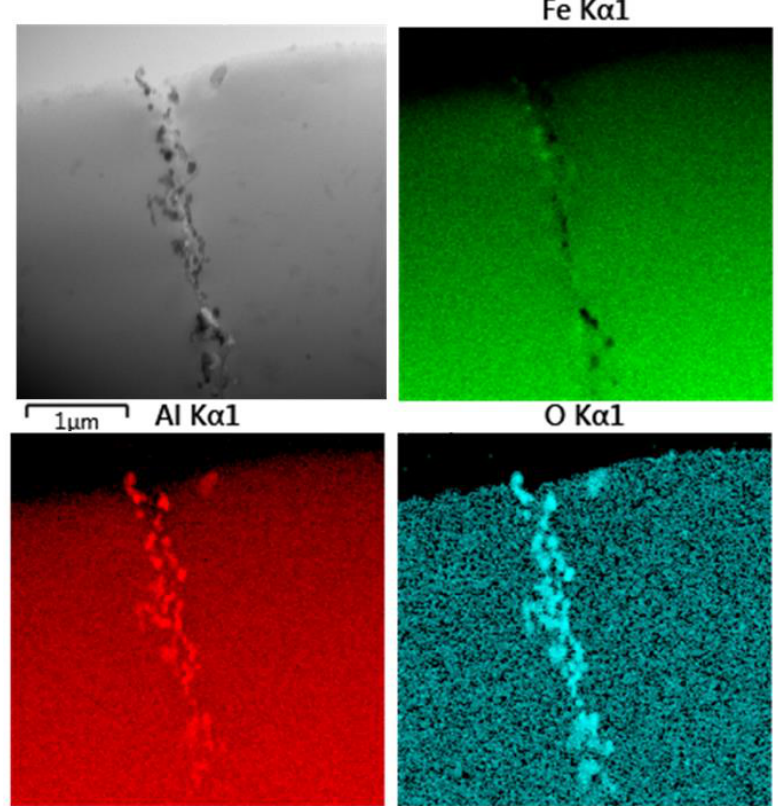
Figure 9. STEM/BF detailed micrographs and EDS elemental maps of Fe28Al SPS compacted at 1100 °C sintered from the initial powder.